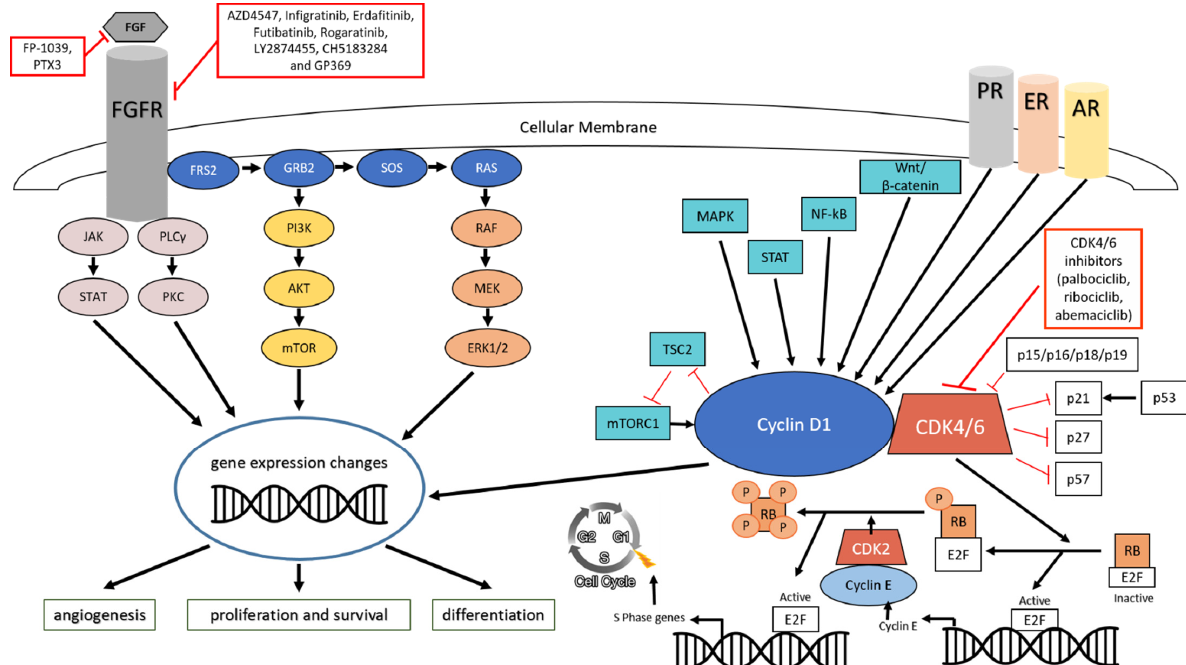
Figure 1. Fibroblast growth factor-FGF receptor (FGF-FGFR) and cyclin D-cyclin-dependent kinase (CDK)4/6 pathways in breast cancer. The molecular components of these signaling pathway and their connections are indicated, together with the available inhibitors that target FGF, FGFR, or CDK4/6.